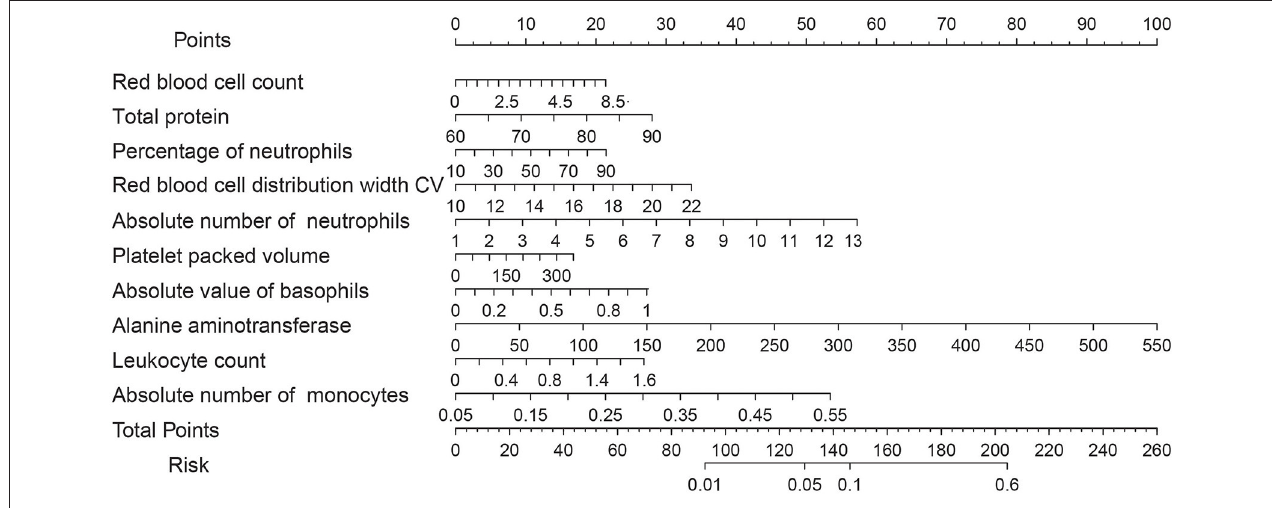
FIGURE 3 | Study population for multivariate logistic regression analyses.